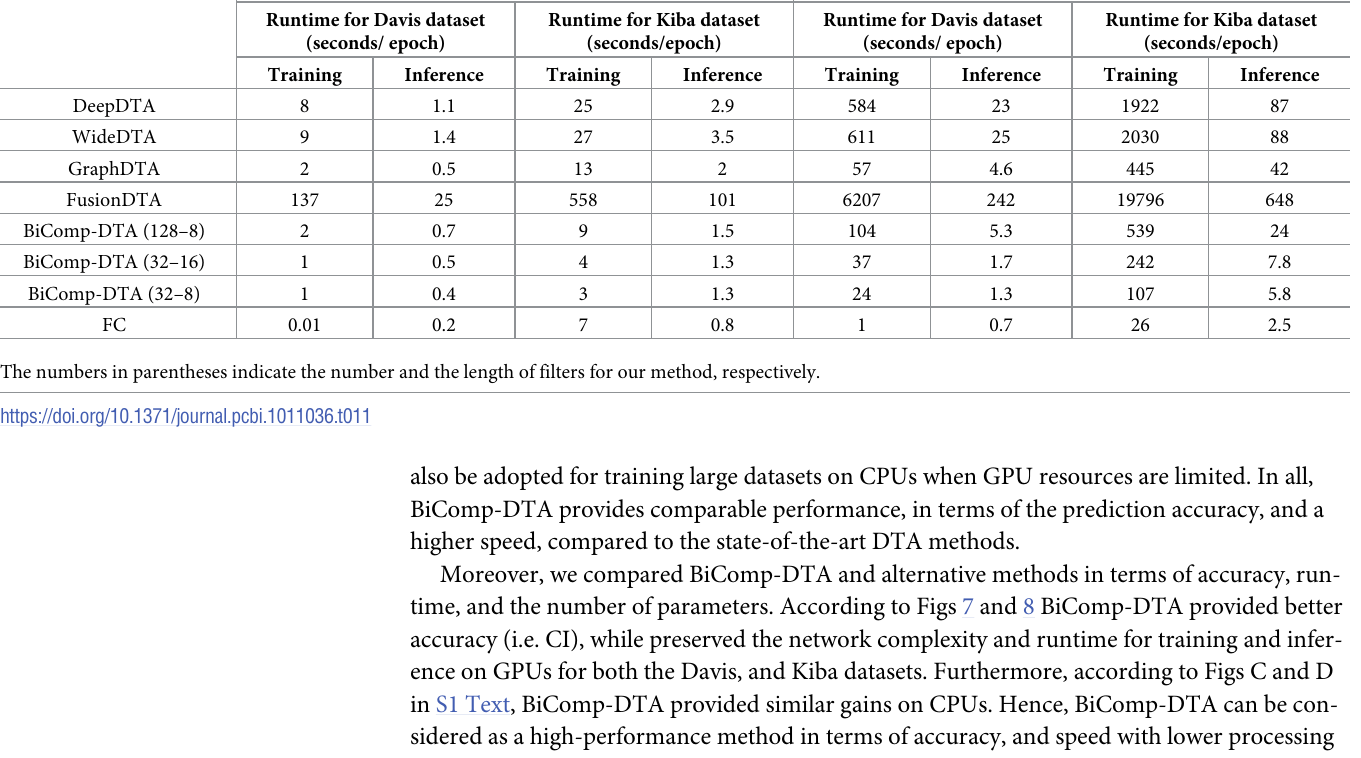
Table 11. Comparing the BiComp-DTA against the alternative methods, i.e. DeepDTA, WideDTA, GraphDTA, FC, and FusionDTA, in terms of the training and inference times on GPUs and CPUs (seconds/epoch). Method